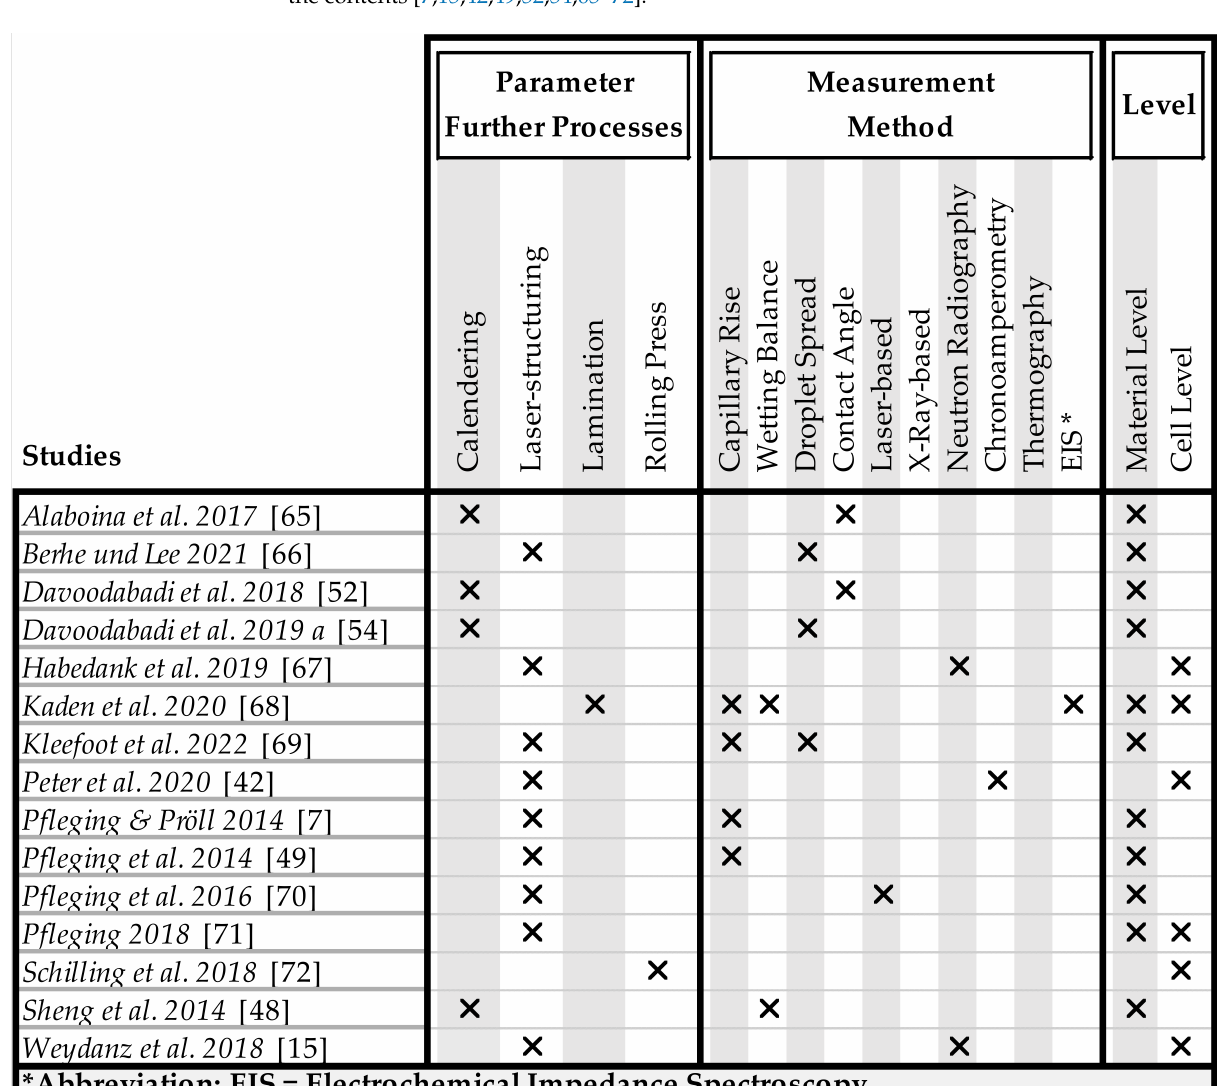
Table 3. Overview of publications assigned to the category Further Processes with a classification